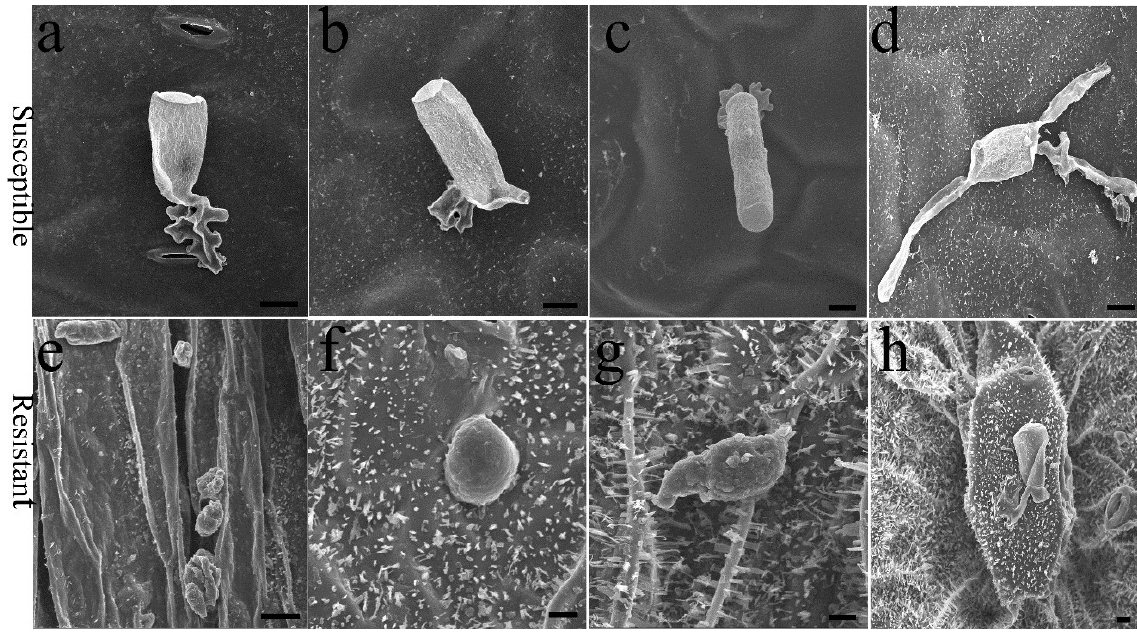
Figure 2. Scanning electron micrographs of E. cruciferarum developing on rapeseed leaves. Host cell penetration and formation of appressorium on the stomatal cell ( a ), pavement cell ( b ) or furrow between cells ( c ) of susceptible plant ‘ZS11’. Secondary hyphal growth after cell penetration ( d ). Dead spores on the foliar epidermis of the moderately resistant plant in the BC 1 F 3 population ( e ), highly resistant ‘BCWF’ ( f ) and penetration-resistant ‘WF’ ( g ) after PM invasion. Scabs/nodules formed by the shrinkage and condensation of the tissue around the PM infection site ( h ). Scale bars represent 50 µ